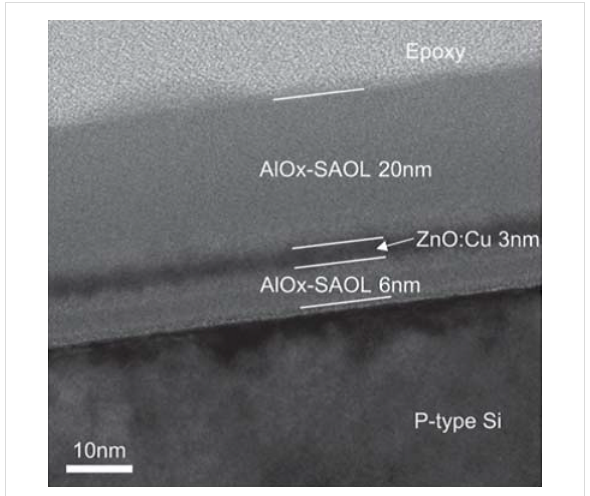
Figure 13: An HRTEM image of a capacitor memory device fabricated by using Al-containing hybrid (marked as AlOx-SAOL) as blocking and tunneling layers with a ZnO:Cu charge trap layer in between (reprinted with permission from [46], Copyright (2012) The Royal Society of